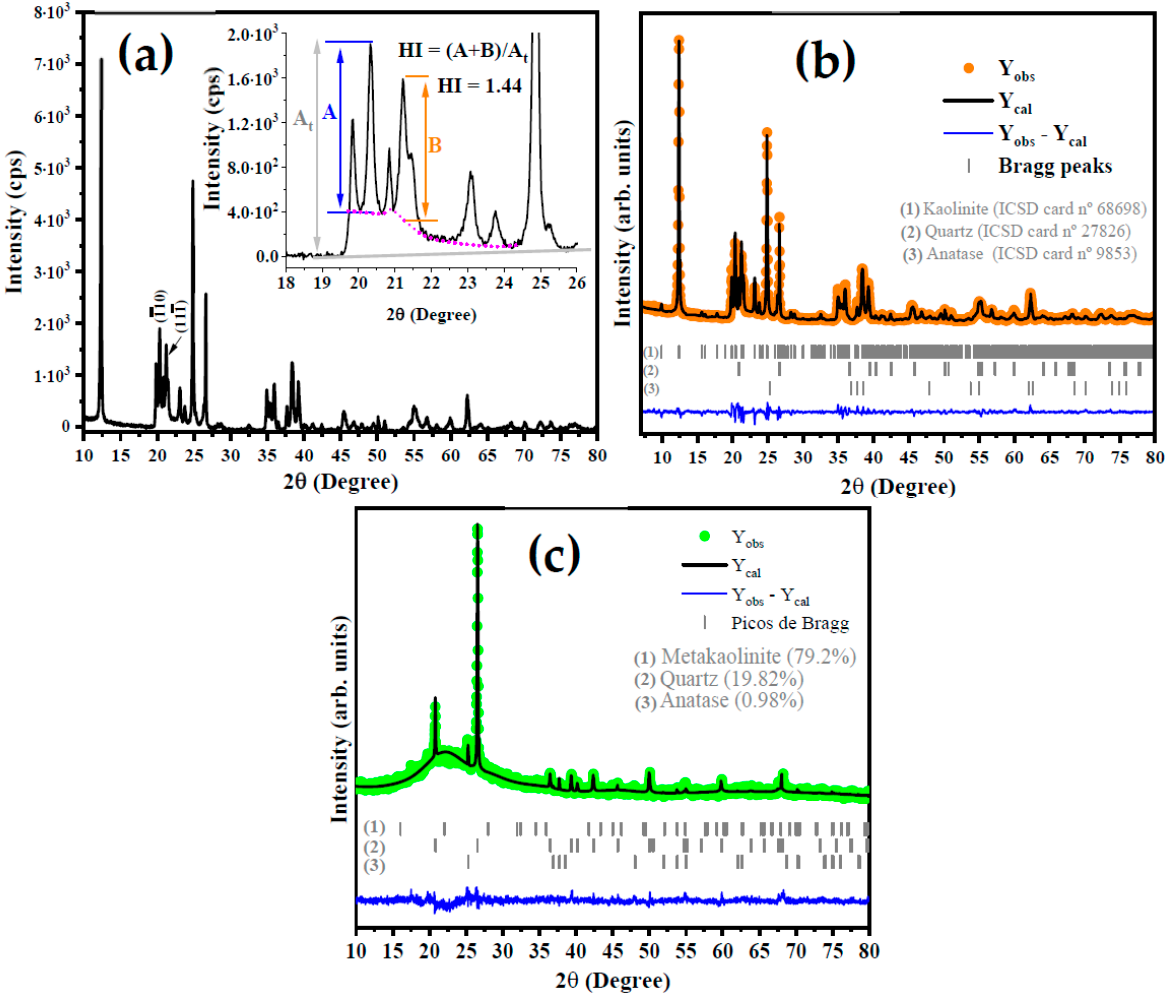
Figure 2. Diffractogram of kaolin with HI calculation model ( a ) and structural Rietveld refinement plot for kaolinite ( b ) and metakaolinite ( c ).